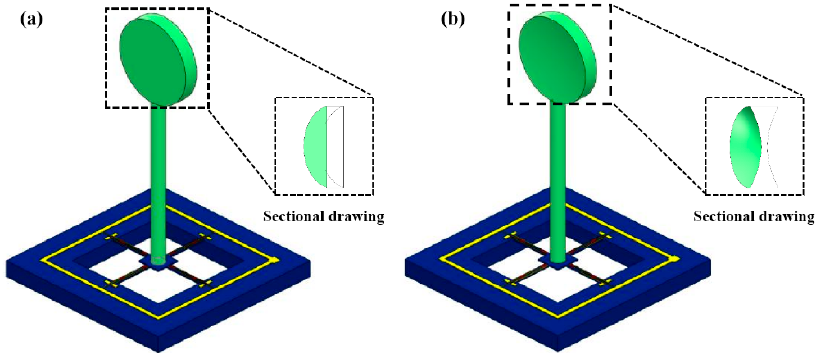
Figure 4. ( a ) Integrated micro-structure model of the planar cilium. ( b ) Integrated micro-structure model of the hollow concave cilium.